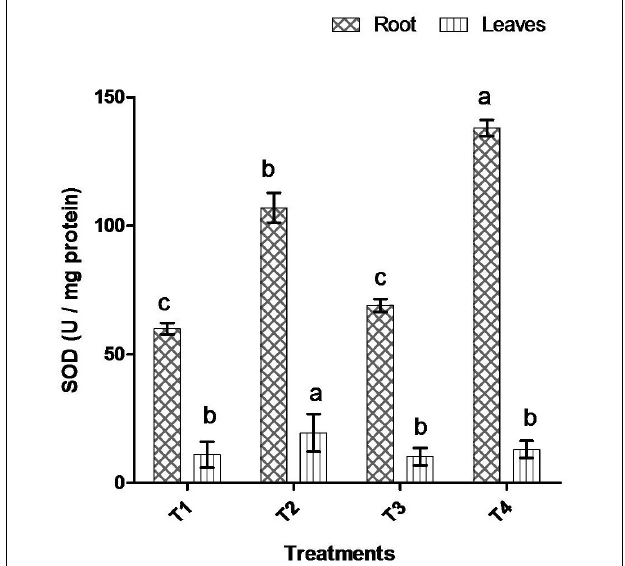
FIGURE 5 | Effect of bacterial (BHU-AV3) inoculation on superoxide (SOD) activity in root and leaves under salt stress. T1 – control, T2 – salt (NaCl), T3 – bacterial (BHU-AV3) inoculation, and T4 – bacterial inoculation + salt. Values represent the mean ± SD, n = 3. Different letters on each bar indicate significant differences ( P = 0.05) after DMRT